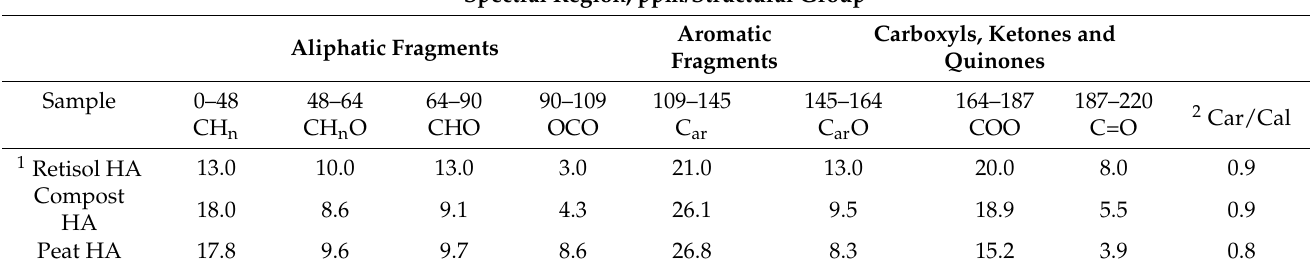
Table 3. Distribution of carbon atoms by structural fragments in the HA (solution-state 13C-NMR spectroscopy), % of the total area of the spectrum.